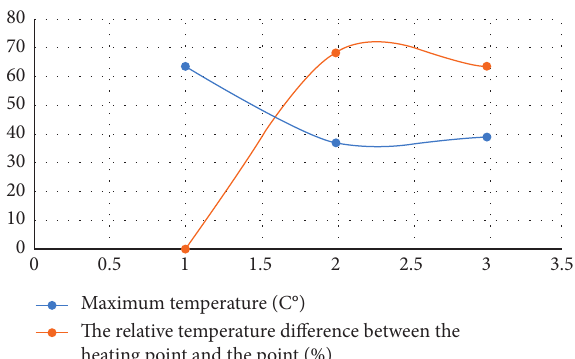
Figure 3: Table of the relative temperature difference between the abnormal heating point and the corresponding normal temperature part.